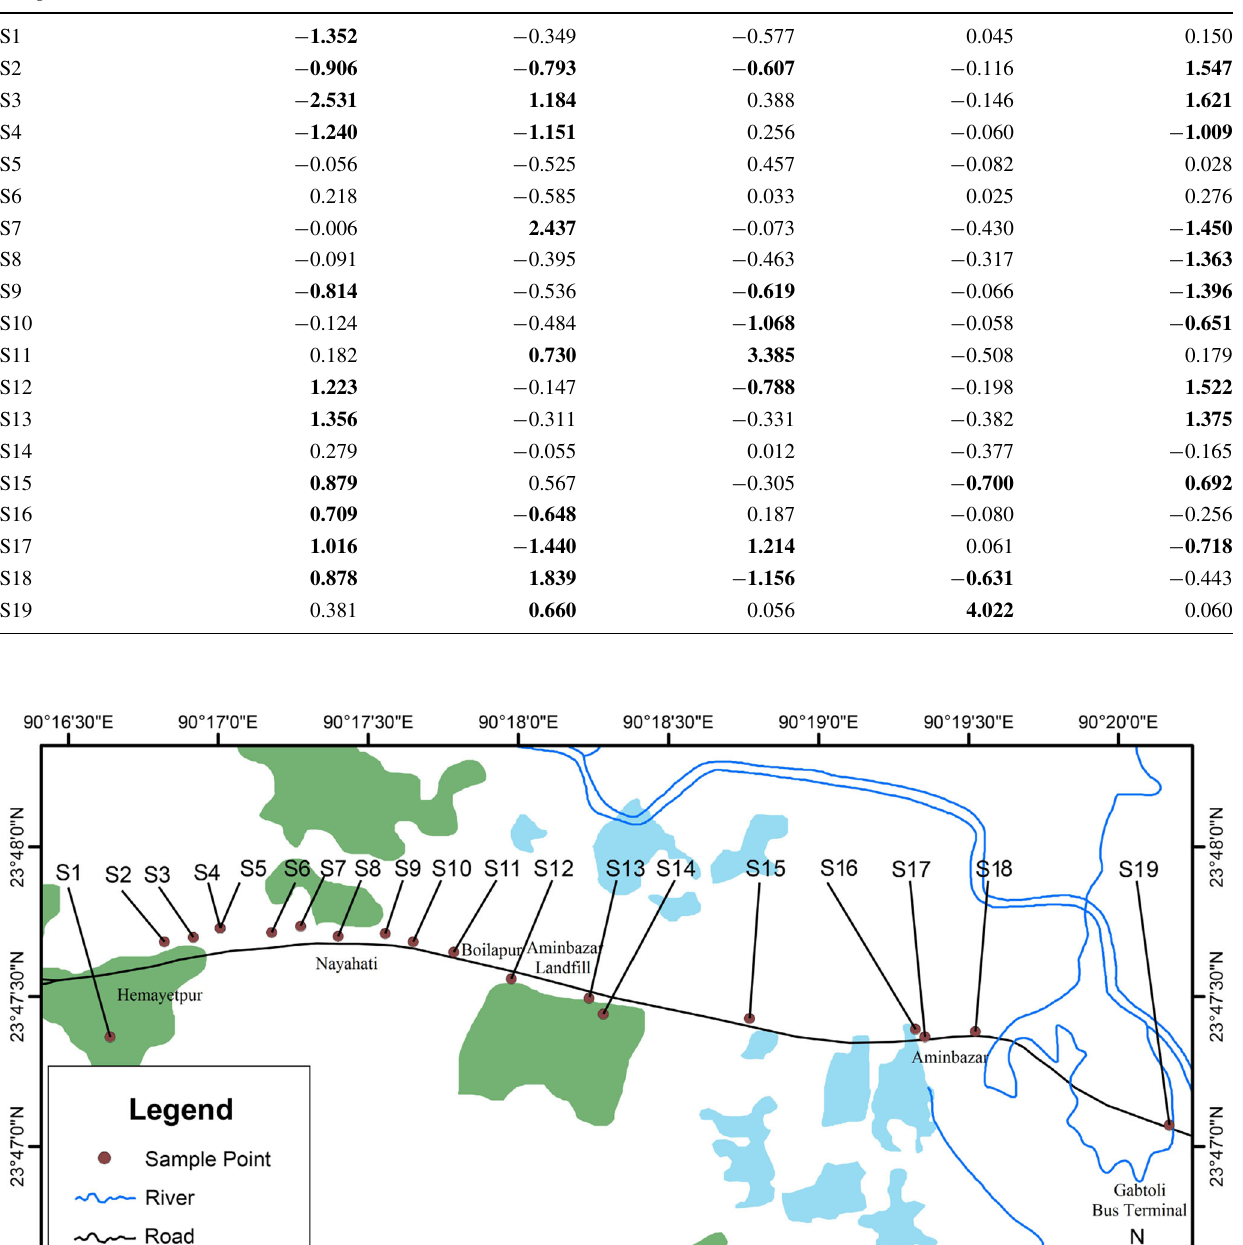
Table 4 Rotated component matrix of five factor model for sampling site with moderate to strong loadings in bold typeface Sample